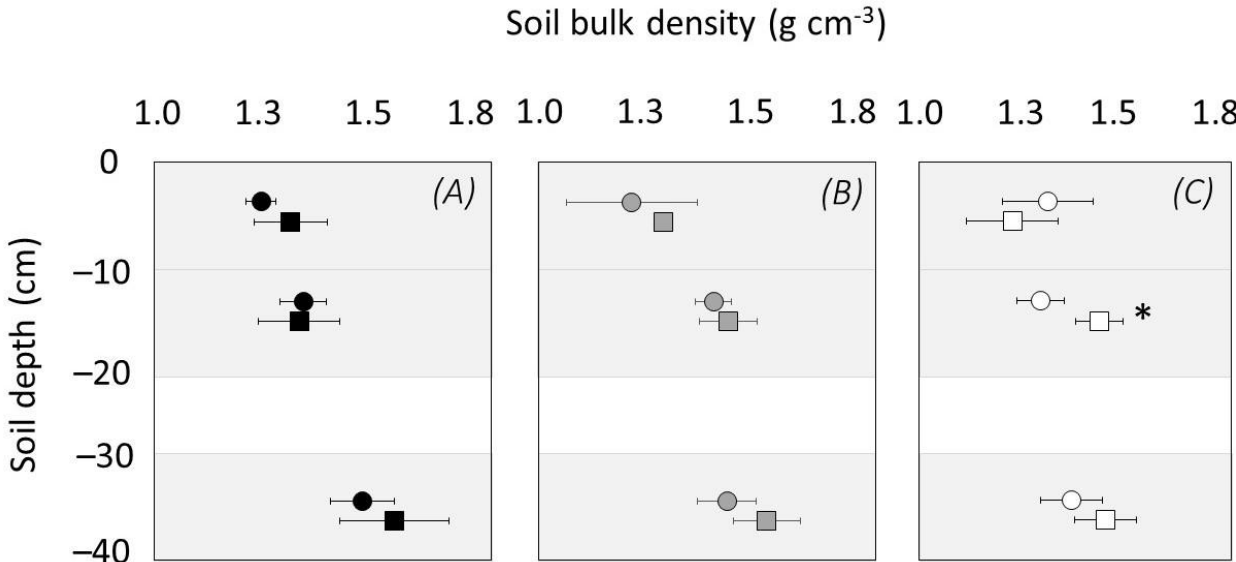
Figure 3. Soil bulk density (g cm − 3 ) at 0–10, 10–20 and 30–40 cm depth in the autumn ploughed ( A ), the autumn cultivated ( B ) and the spring cultivated ( C ) treatments in September 2019 (circles) and 2020 (squares). Data are presented as means (N = 4) with standard error deviations. Asterisks (*) indicate significant difference between 2019 and 2020 within soil depth and treatment.